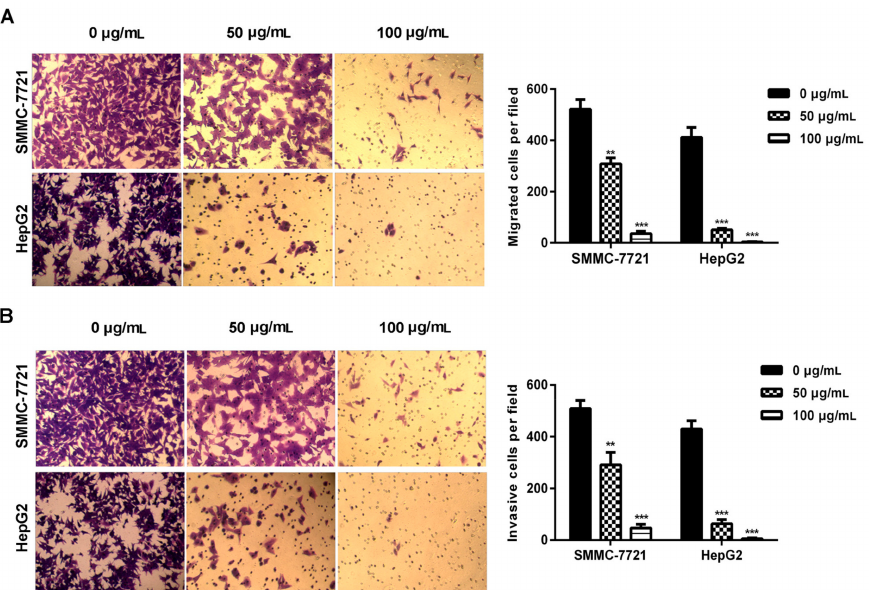
Figure 2. Daucosterol reduced the migration and invasion of HepG2 and SMMC-7721 cells. ( A ) Transwell assays were performed to evaluate the migration of SMMC-7721 and HepG2 cells treated with 0, 50, and 100 µ g/mL daucosterol for 48 h (*** p < 0.001); ( B ) Cell invasion was detected via transwell assays in SMMC-7721 and HepG2 cells treated with 0, 50, and 100 µ g/mL daucosterol for 48 h (** p < 0.01, *** p <